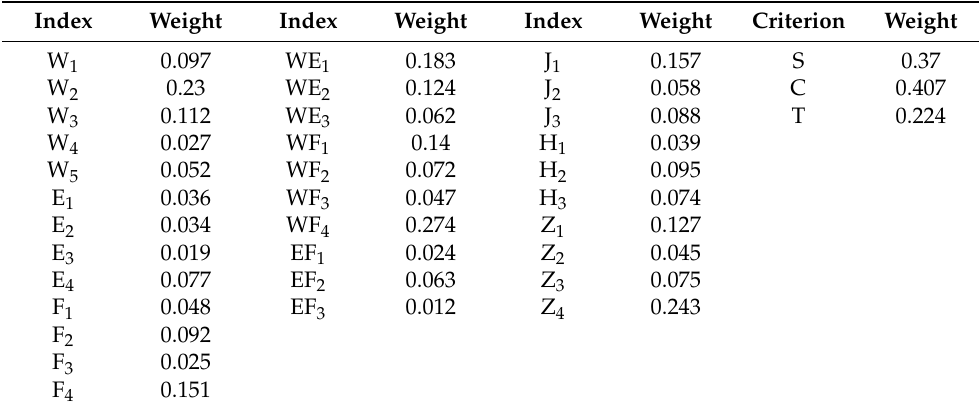
Table 3. Weights of